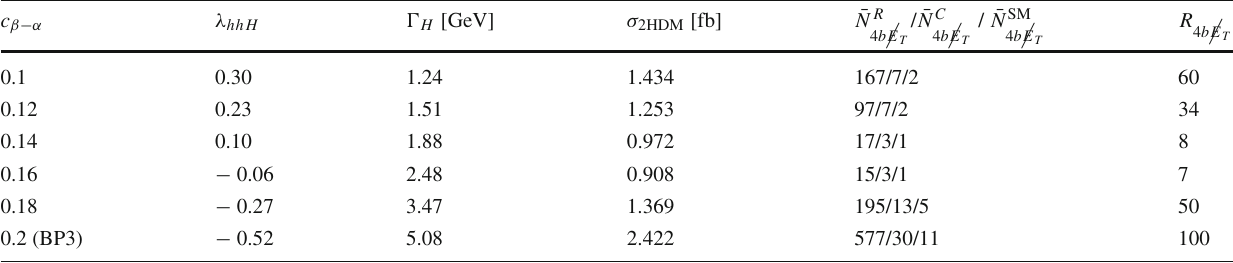
√ s = 3000 GeV. Also shown are λ hhH , the total widths (cid:16) H , total cross sections, σ , and event Table 7 R for BP3 for different c β − α at 4 b (cid:3) E T numbers, ¯ N , as defined in the text. “–” indicates values that cannot be evaluated due to a too small number of events